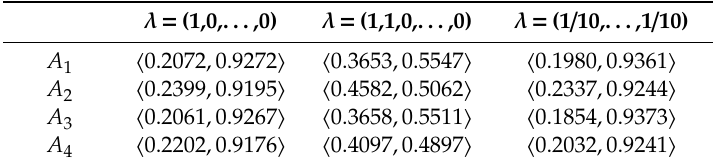
Table 1. The comprehensive evaluation values, obtained by taking di ff erent settings of the parameter vector λ .